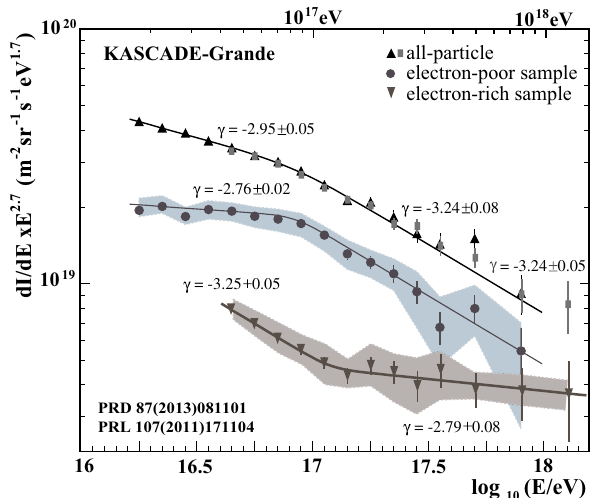
Fig. 7 All-particle, electron-poor, and electron-rich energy spectra from KASCADE-Grande